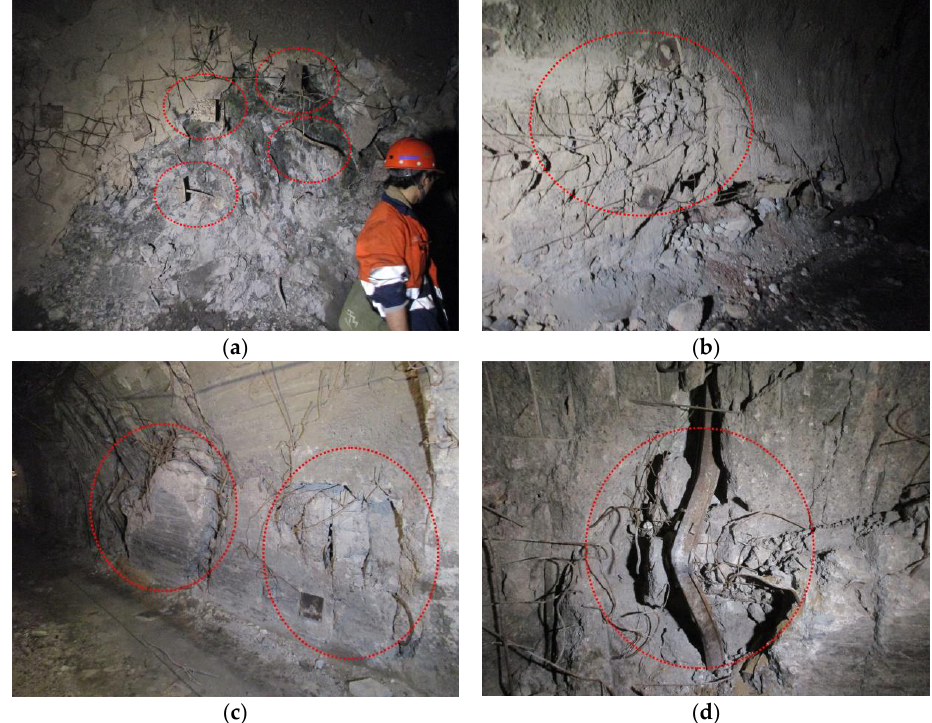
Figure 8. Support failure modes: ( a ) Bolt pulled out and slipped, ( b ) Wire mesh twisted and snapped, ( c ) Shotcrete cracked and extruded, ( d ) U-shaped steel extruded and bent.